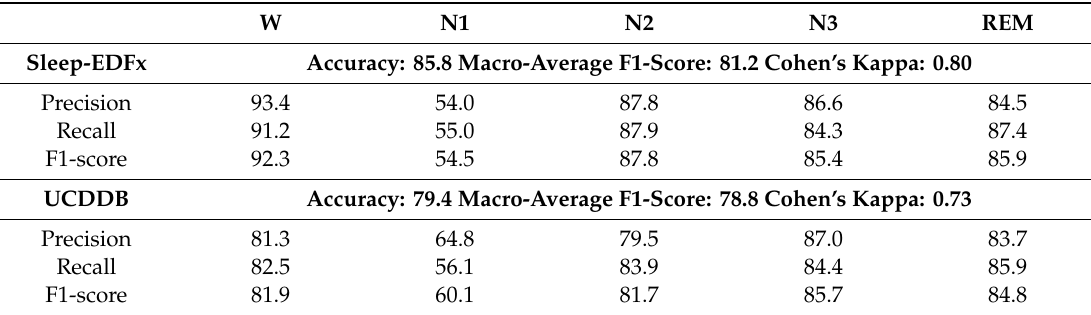
Table 4. Overall performance of the proposed